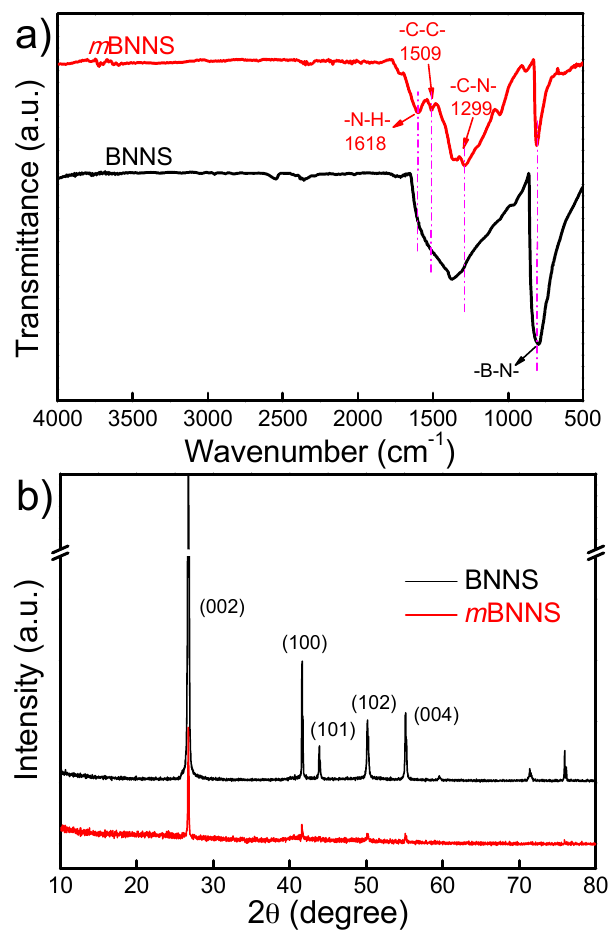
Figure 2. ( a ) Fourier-transform infrared (FT-IR) spectra and ( b ) X-ray diffraction (XRD) patterns for boron nitride nanosheets (BNNS) and m BNNS particles, respectively.